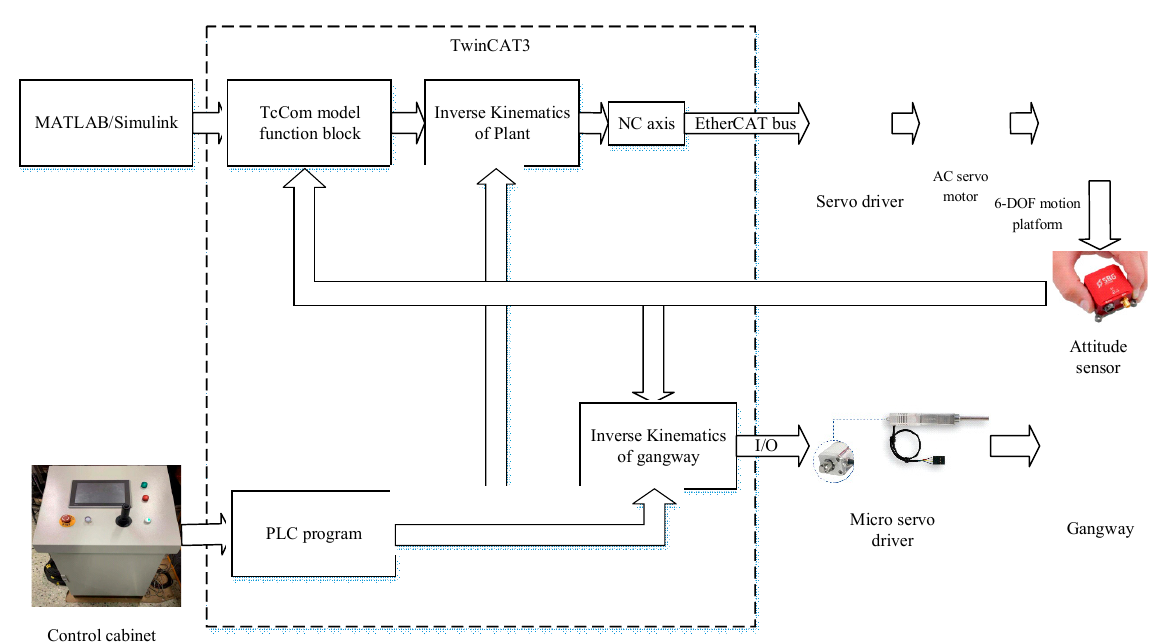
Figure 16. Control Diagram of the hardware-in-the-loop simulation system.